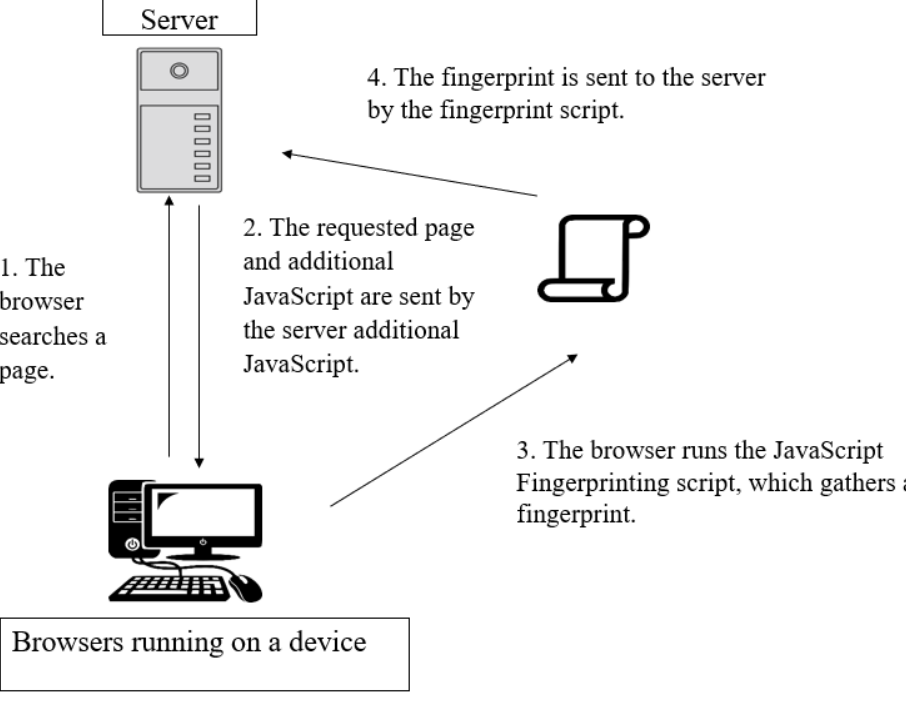
Figure 2. Summary of the browser fingerprinting procedure.